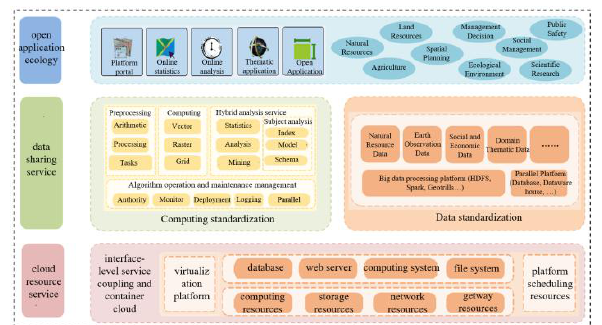
Figure 2. Elastic hybrid cloud computing ecological and distributed spatial analysis